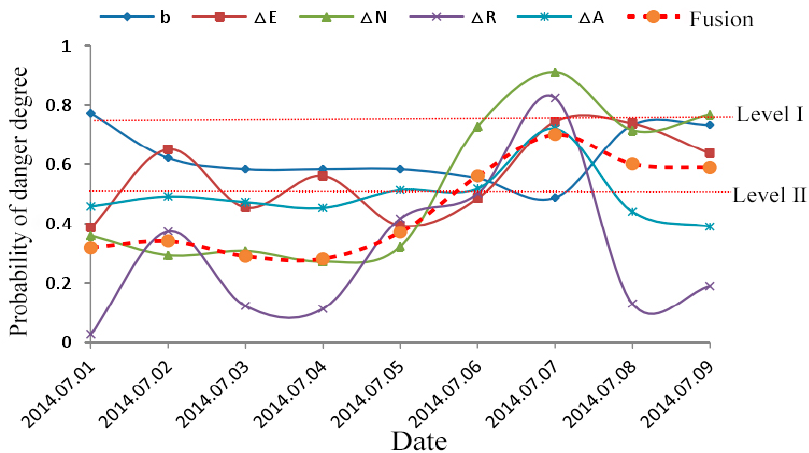
Figure 11. Prediction of rockburst on 8 July 2014.